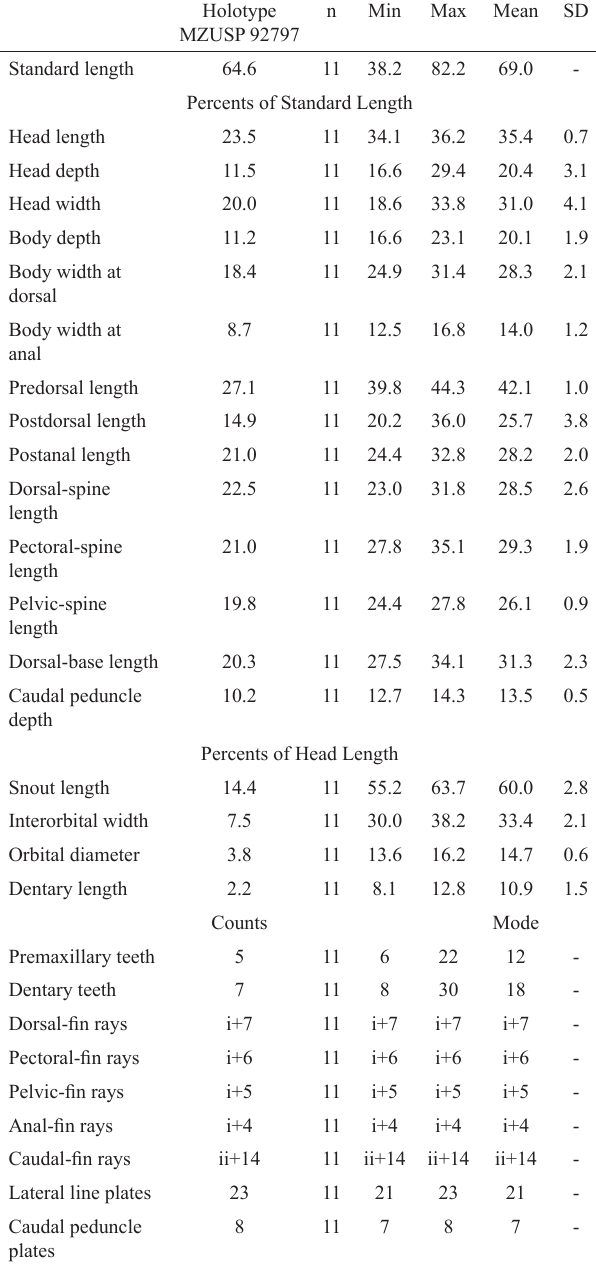
Table 3. Morphometric and meristic data of Spectracanthicus immaculatus . Values are given as percents of standard length or head length. SD = standard